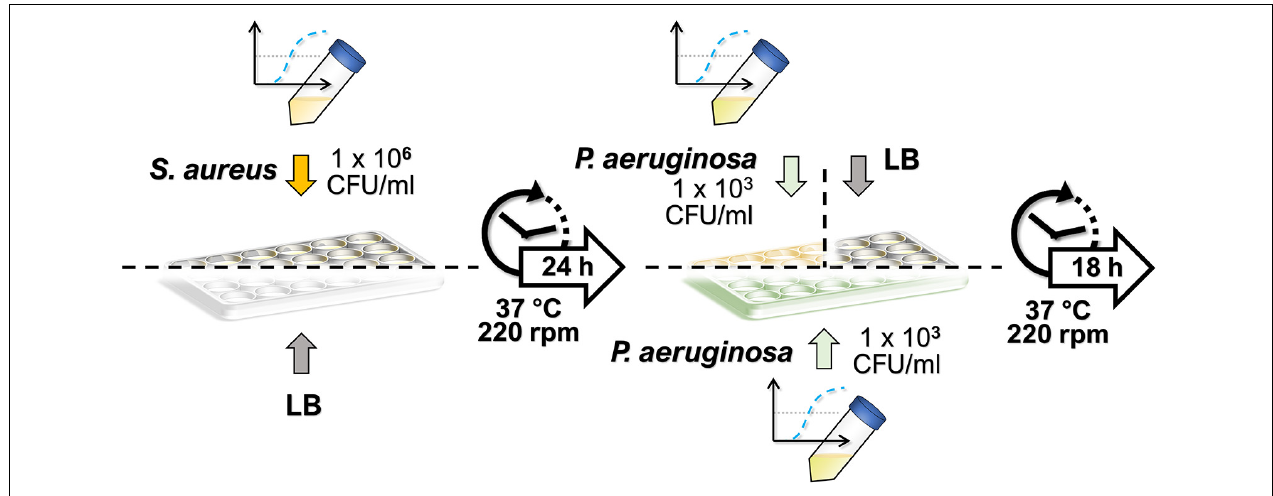
FIGURE 1 | Culturing protocol of dual-species biofilms. Staphylococcus aureus biofilms were allowed to develop for 24 h, after which a low-concentration inoculum of Pseudomonas aeruginosa was added, and the dual-species biofilm was incubated under the same culture conditions for 18 h. Single-species biofilms were obtained by adding sterile lysogeny broth in place of the second species during culturing.